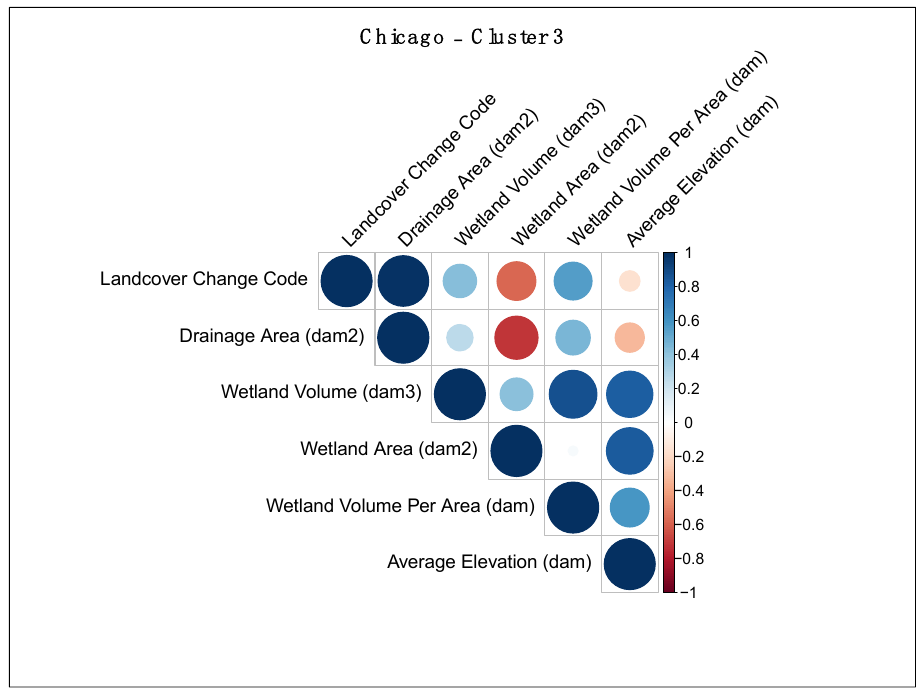
Figure 11. Chicago cluster 3 correlation matrix.